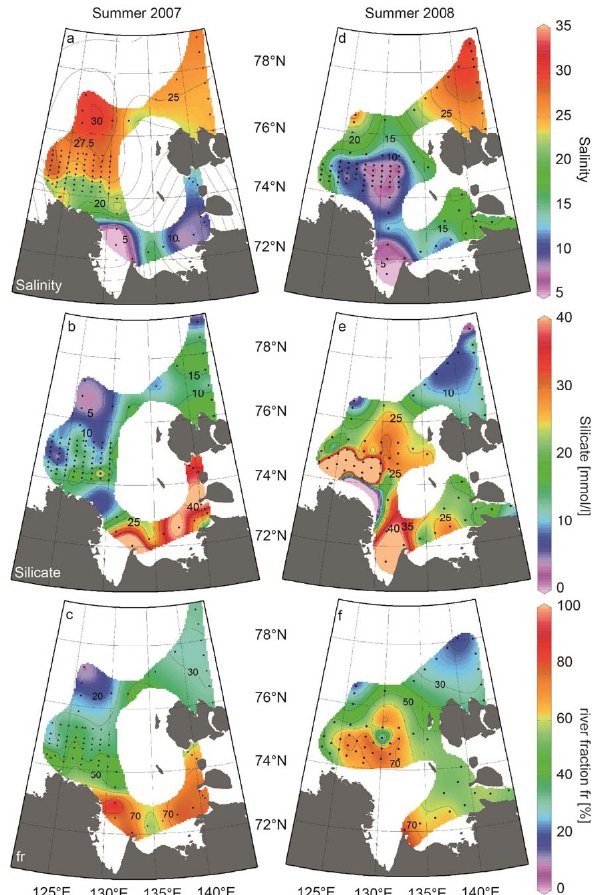
Fig. 3. The surface distribution of salinity ( a , d ; [psu]), silicate con- centration ( b , e ; [µmolL − 1 ]), and δ 18 O-derived river water fraction fr ( c , f ; [%]) indicates the different spreading of river-dominated surface waters during TD XII (summer 2007) and TD XIV (sum- mer